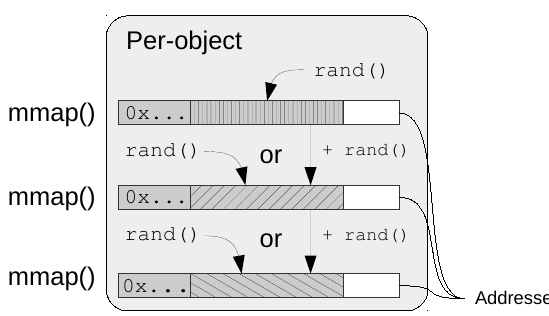
Figure 2. Per-object randomization.